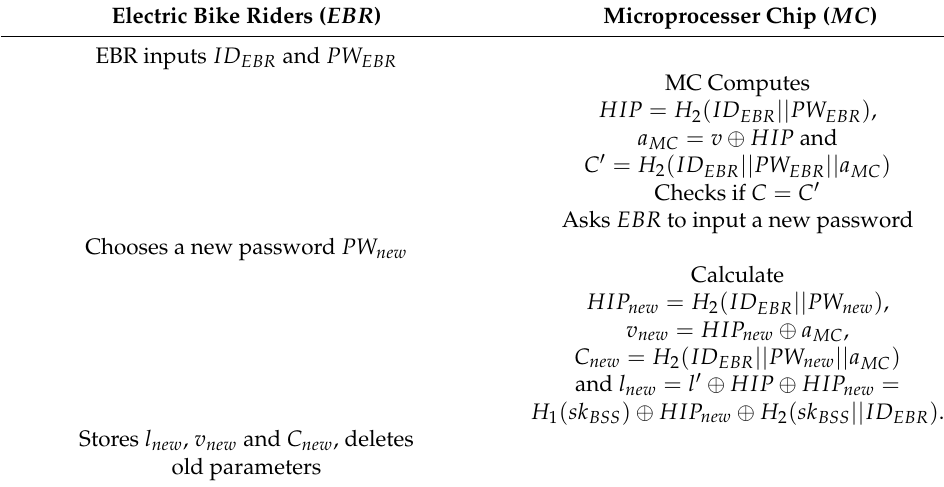
Table 5. Password change activity.